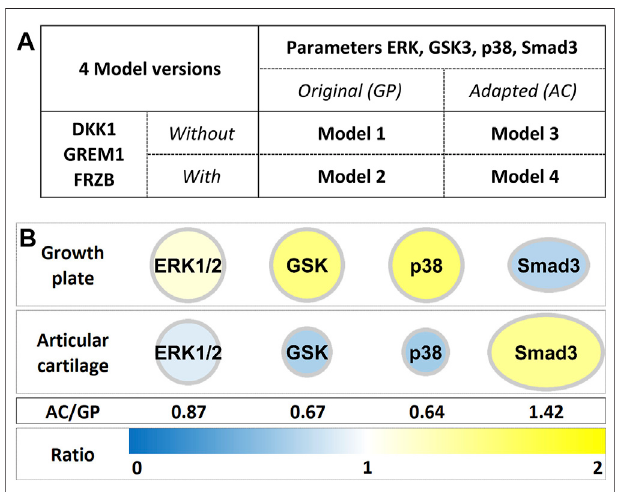
FIGURE 1 | (A) Adaptation of ECHO resulted in 4 model versions, depending on the presence or absence of DKK1, FRZB and GREM1 and the changes in parameters of ERK1/2, GSK, p38 and SMAD3. (B) Model parameters of ERK1/2, GSK3 β , p38 and SMAD3 were adapted to previously found differences in growth plate and articular cartilage mRNA expression (Leijten et al., 2012; Schivo et al.,